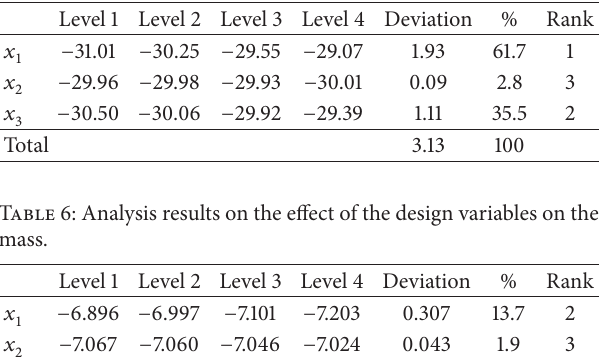
Table 5: Analysis results on the effect of the design variables on the maximum stress.